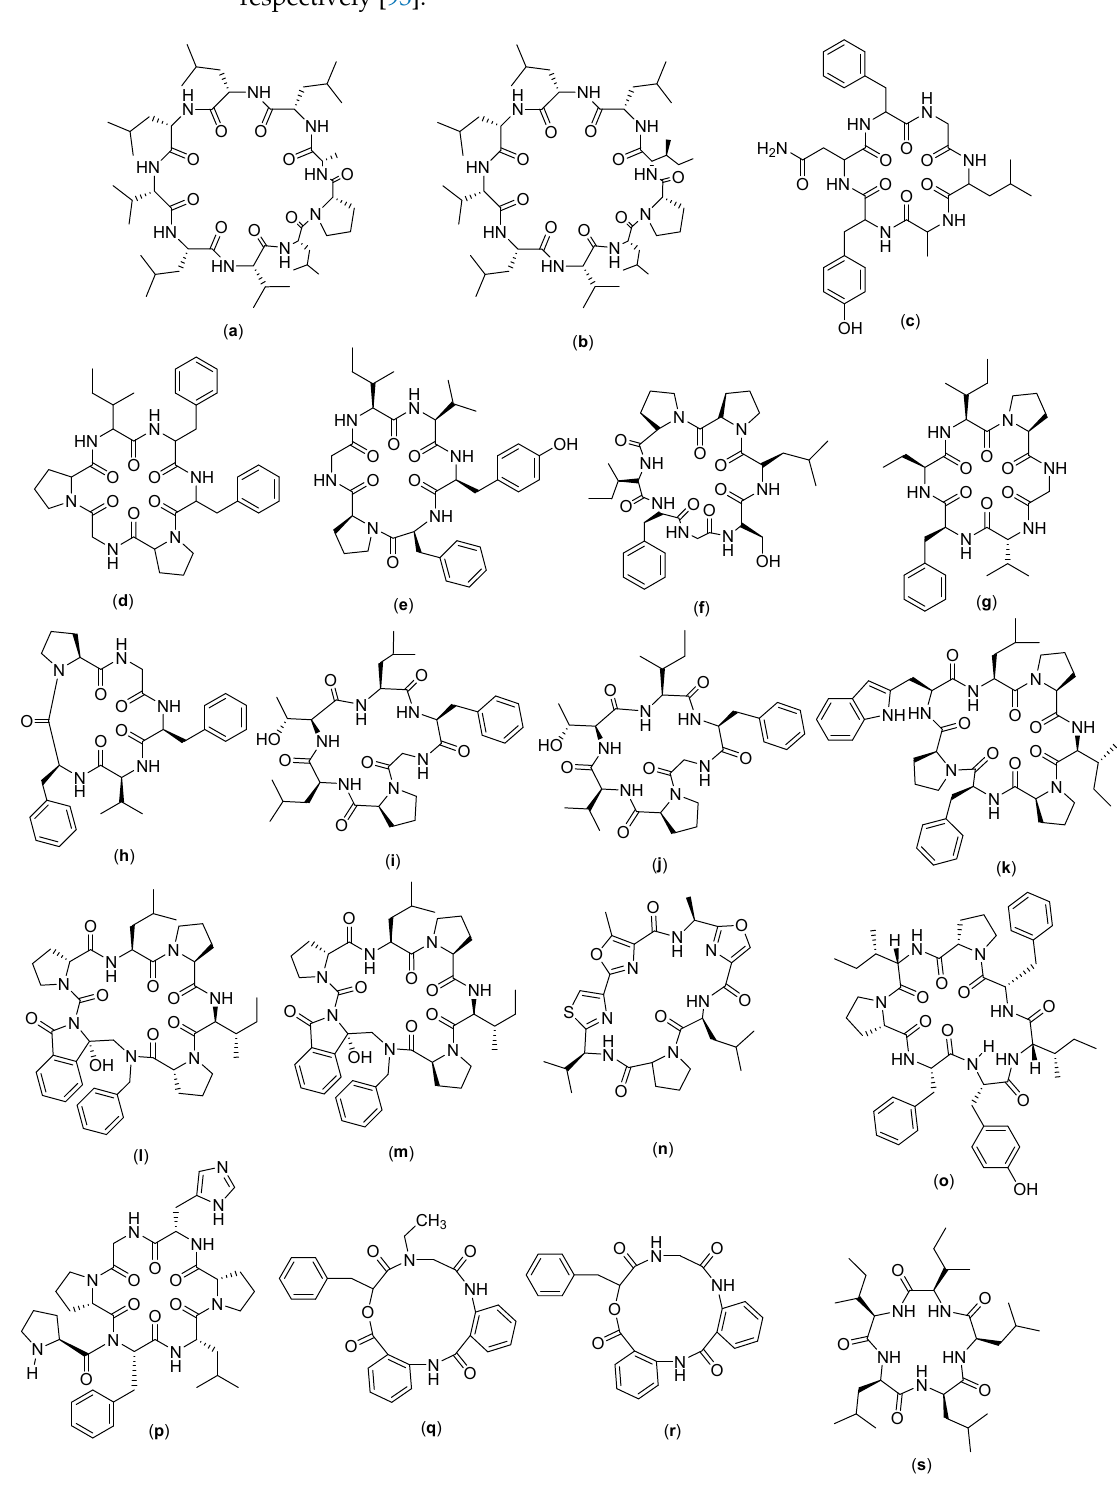
Figure 8. Structure of ( a ) Grifficyclocin B; ( b ) GG-8-6; ( c ) Dianthin A; ( d ) Dianthin B; ( e ) Dianthin C; ( f ) Dianthin D ( g ) Dianthin E; ( h ) Dianthin F; ( i ) Dianthin G; ( j ) Dianthin H; ( k ) Phakillestatin 6; ( l ) Analogs phakellistatin 6 (DLD-S); ( m ) Analogs phakellistatin 6 (LLD-S); ( n ) Leucamide; ( o ) Stylis- satin A; ( p ) Stylissatin B; ( q ) Clavatustide A; ( r ) Clavatustide B; and ( s ) Clavatustide C.